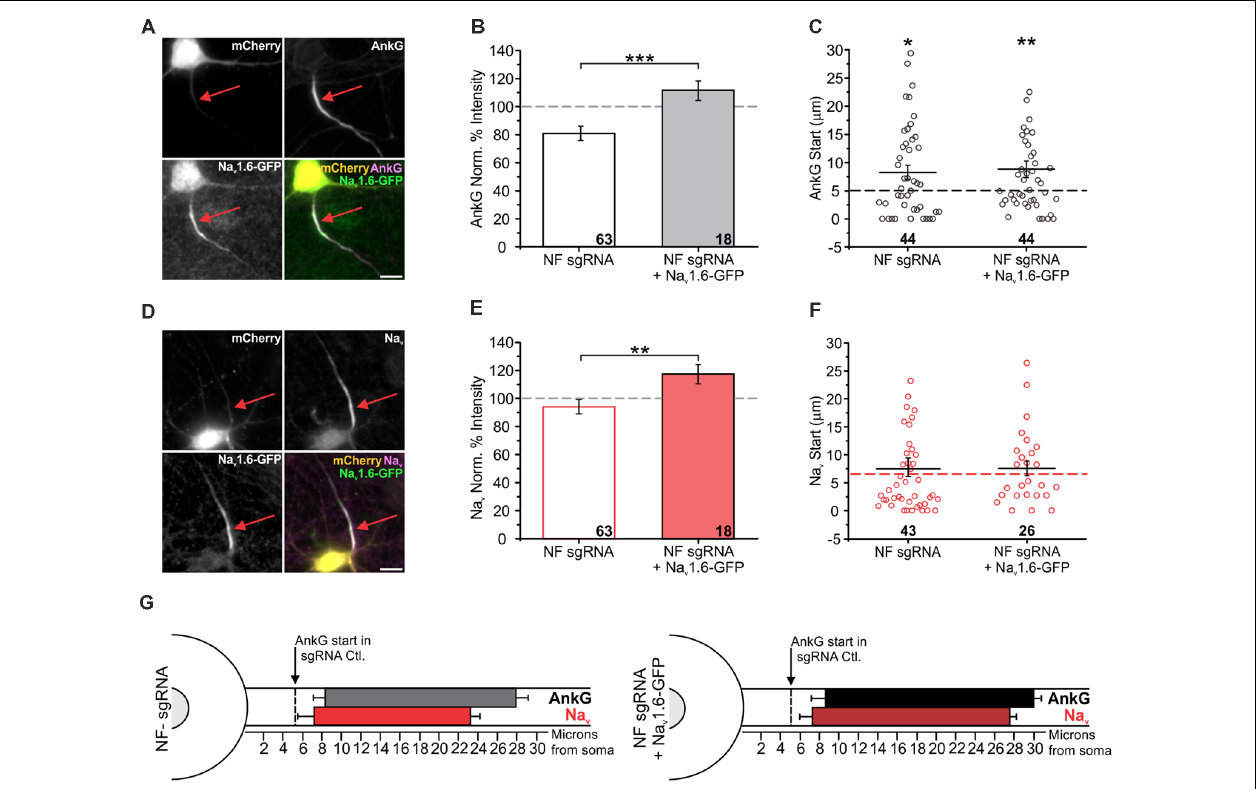
FIGURE 5 | Na v 1.6 overexpression rescues AnkG enrichment, but not translocation. (A,D) Representative images for NF sgRNA + Na v 1.6-GFP co-transfected neurons stained for mCherry, GFP, and AnkG (A) or panNa v (D) . Red arrows indicate the AIS of transfected neurons. Scale bars: 10 µ m. (B,E) Ratio of mean fluorescence intensity for AnkG (B) and Na v (E) at the AIS in NF sgRNA (originally from Figure 3 ) or NF sgRNA + Na v 1.6-GFP expressing neurons normalized to untransfected neurons in the same image ( B : NF sgRNA n = 63; NF sgRNA + Na v 1.6-GFP n = 18; ∗∗∗ p < 0.001, Student’s t -test. E : NF sgRNA n = 61; NF sgRNA + Na v 1.6-GFP n = 28; ∗∗ p = 0.0099, Student’s t -test). (C,F) Distance from the soma to start of AIS for AnkG (C) and Na v (F) in NF sgRNA (data originally from Figure 4 ) or NF sgRNA + Na v 1.6-GFP neurons ( C : NF sgRNA n = 44; NF sgRNA + Na v 1.6-GFP n = 44; asterisks indicate statistical significance from sgRNA Ctl.; NF sgRNA ∗ p = 0.012, NF sgRNA + Nav1.6-GFP ∗∗ p = 0.0073, Kruskal-Wallis ANOVA followed by Dunn’s post-test with Bonferroni correction. F : NF sgRNA n = 43; NF sgRNA + Na v 1.6-GFP n = 26). sgRNA Ctl. is displayed as a dashed line for comparison. Error bars indicate mean ± SEM. (G) To-scale distribution of AnkG (black) and Na v (red) in NF sgRNA (left) and NF sgRNA + Na v 1.6-GFP (right) neurons. Color saturation of bars are indicative of average labeling intensity of the population. Dashed black line indicates start of AnkG enrichment in sgRNA control (data originally from Figure 4 ). Left error bar indicates SEM for distance from the soma, right error bar indicates SEM for length; data taken from (B,C) and (E,F)